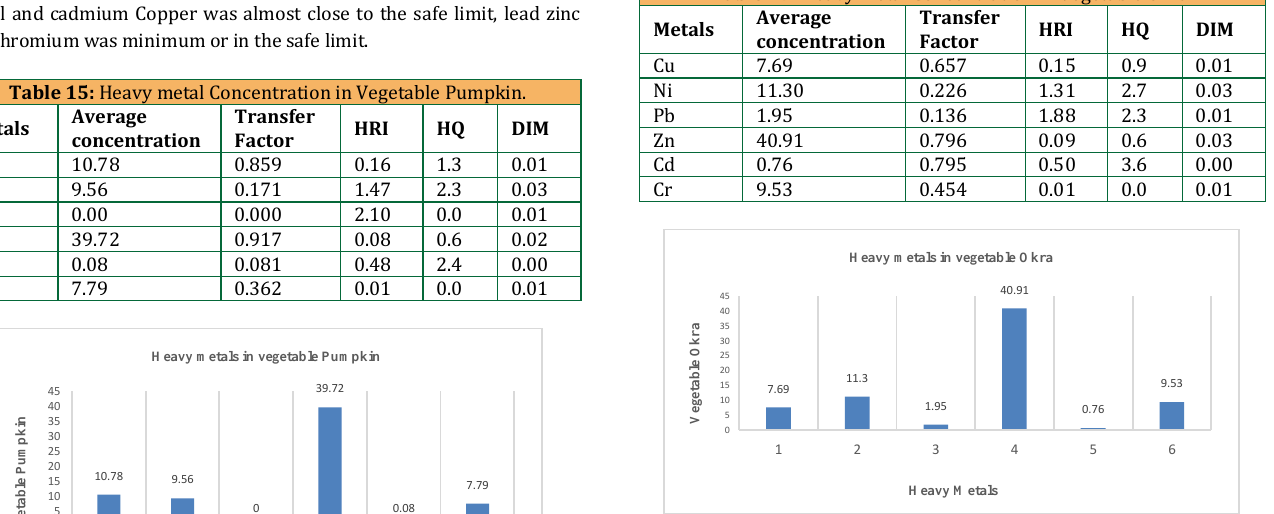
Table 17: Heavy metal Concentration in Vegetable Okra.